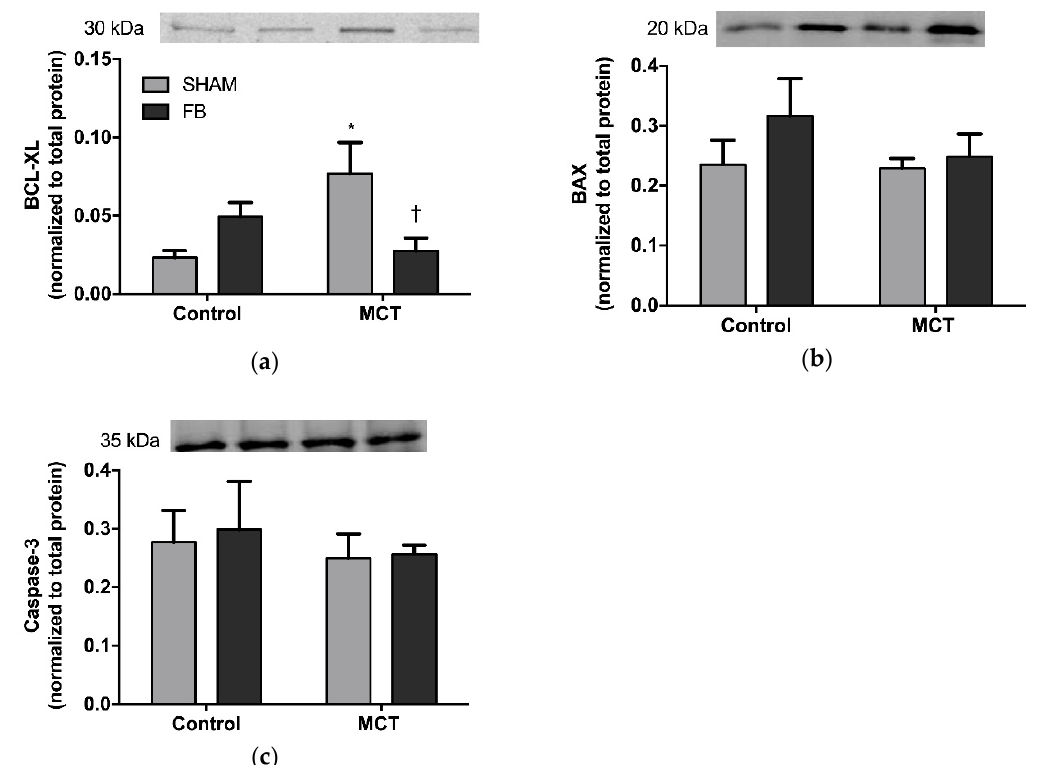
Figure 5. Effect of Xanthohumol-fortified beer (FB) on lung apoptosis of healthy (Control) and monocrotaline (MCT)-induced PAH animals: ( a ) BCL-XL, ( b ) BAX, and ( c ) caspase-3. Data are mean ± SEM from samples of 8 animals per group. * p < 0.05 vs. respective control group, † p < 0.05 vs. MCT + SHAM.